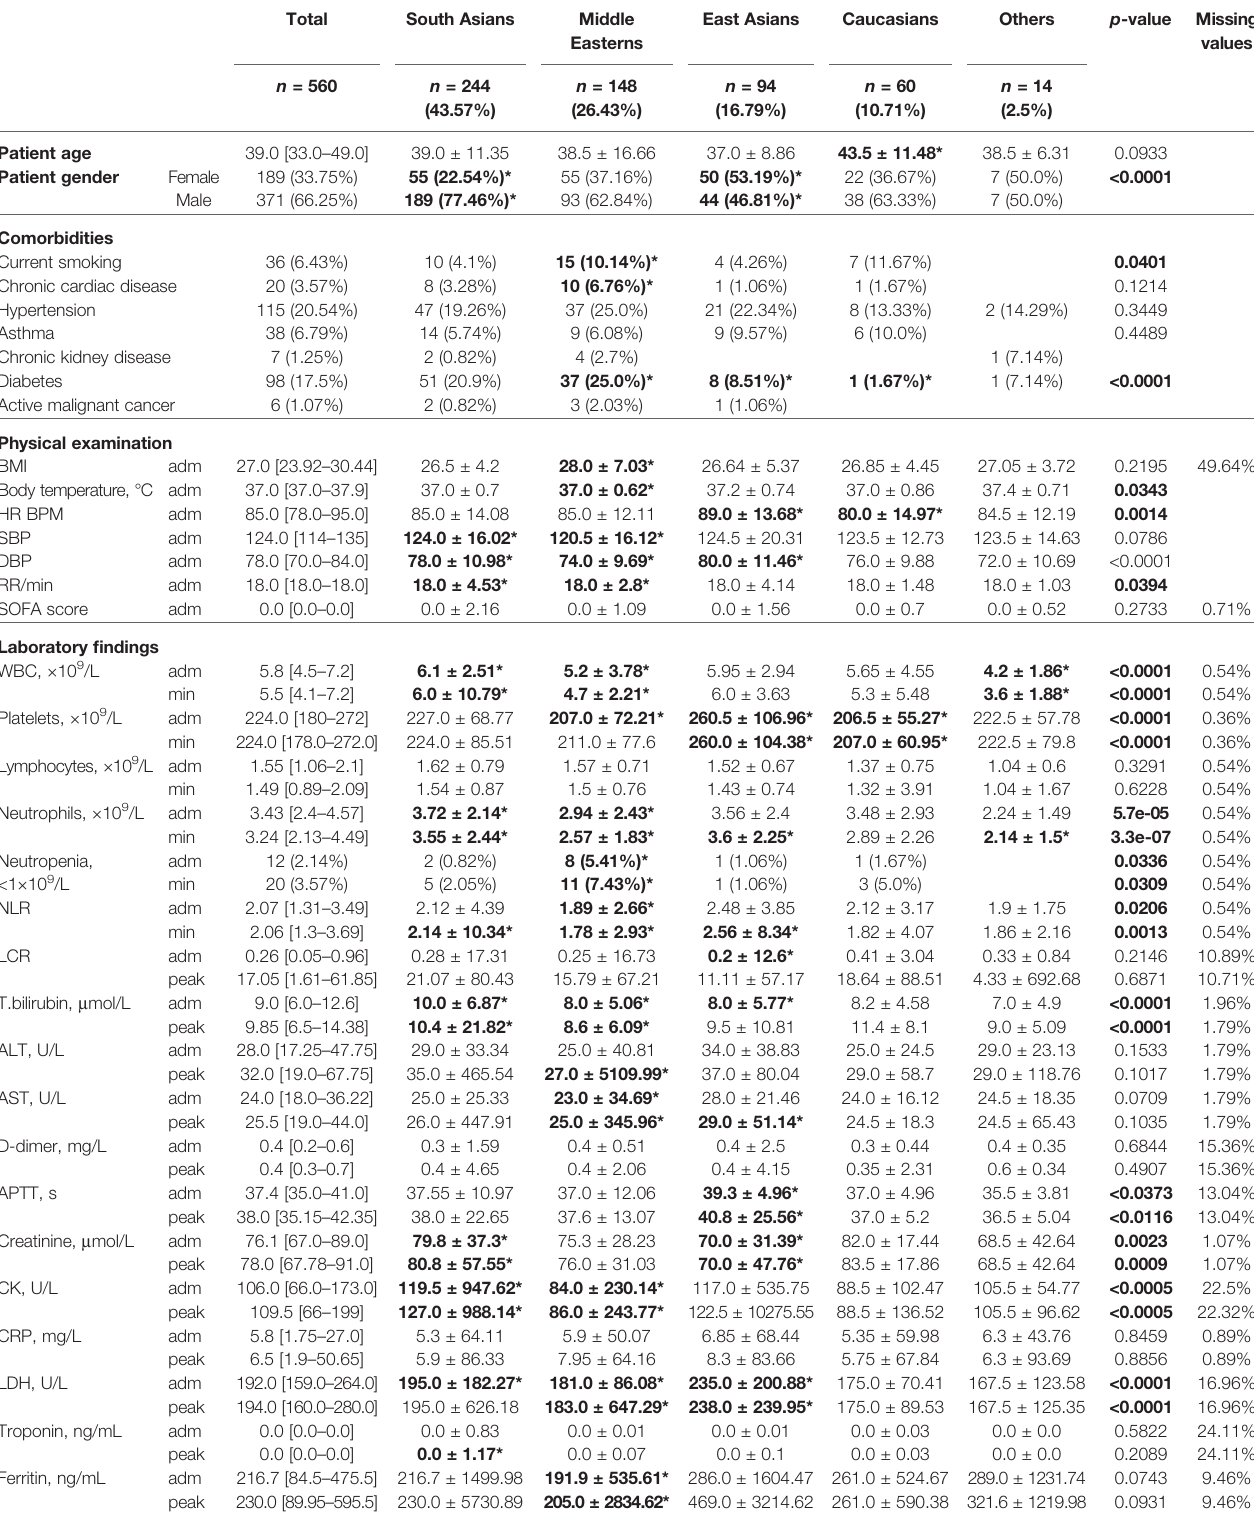
TABLE 3 | Comparison of patients of different ethnic